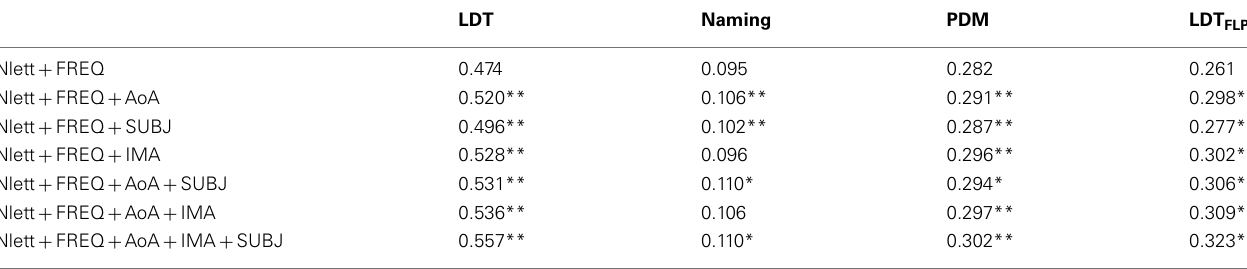
Table 6 | Percentage of variance explained byAoA, subjective frequency (SUBJ), and imageability (IMA) in addition to the variance explained by word length and word frequency.